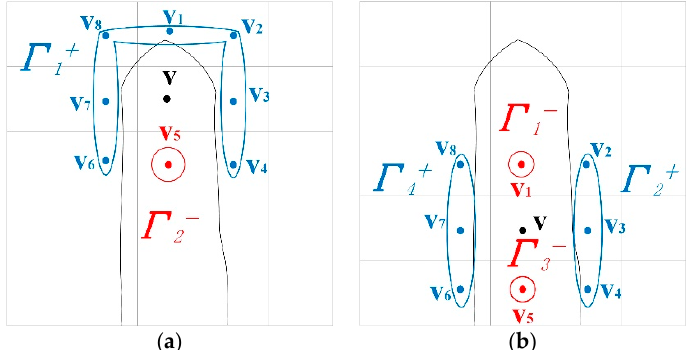
Figure 10. The effect of weak regions detection; ( a ) point clouds are generated from TSDF by Equation (4); the non-critical point is marked blue, and the critical point is marked red; ( b ) a cross-section of a weak region (the green box in figure ( a )); there are many points inside the surface that do not fall on the actual surface; these cause the generated surface mesh model to shrink to the inside of the object.